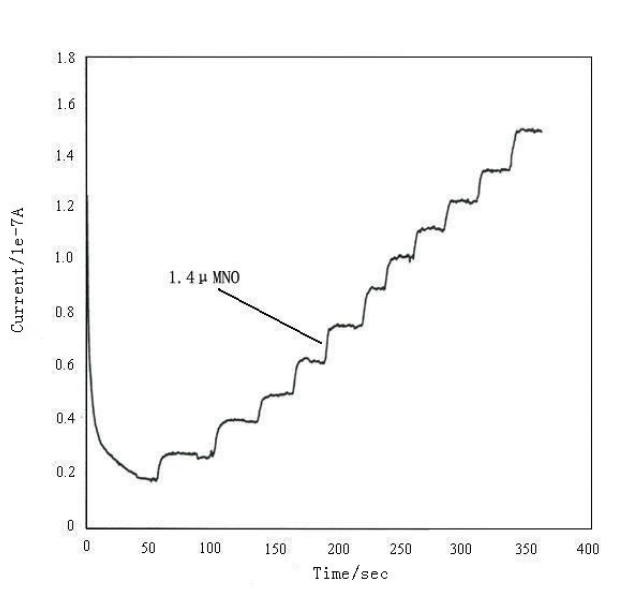
Fig. 1 . current-time curve of the ISO-NOPMC microsensor to the successive additions of NO (each [NO] increment is 1.4 ì M ) in